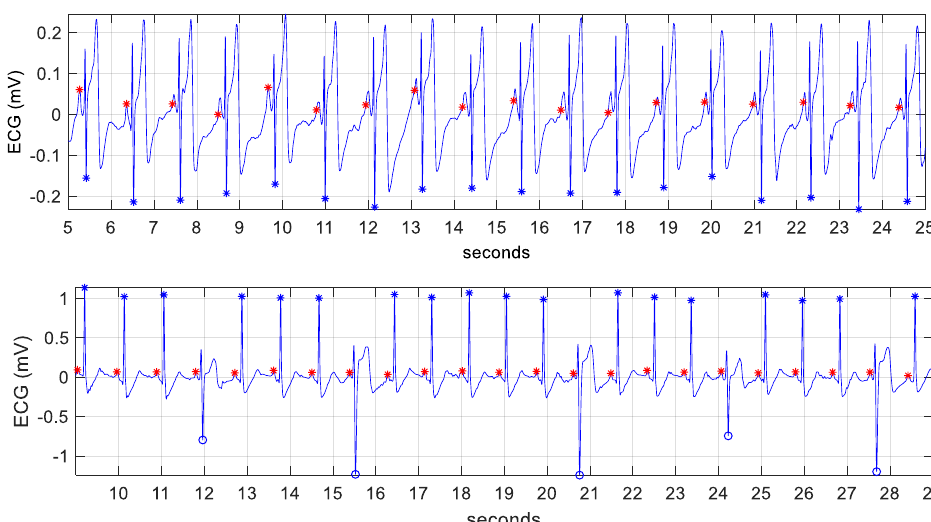
Figure 2. ECG strips with detected normal heartbeats (blue ‘*’), ectopic ventricular beats (blue ‘o’) and P-waves (red ‘*’). The detected heartbeats and P-waves are used for calculation of the time and amplitude criteria in Group 1 and Group 2.